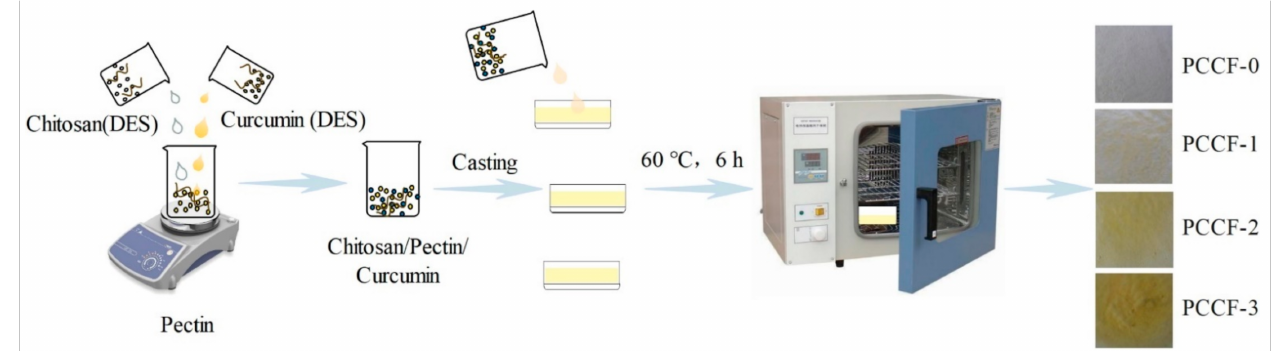
Figure 8. Procedure for preparation of pectin-chitosan-curcumin film